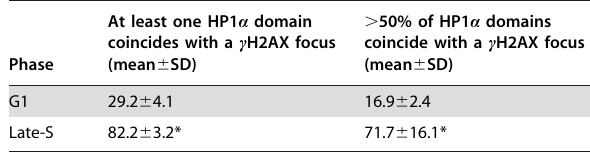
Table 2. Distribution of X-ray induced c H2AX foci in